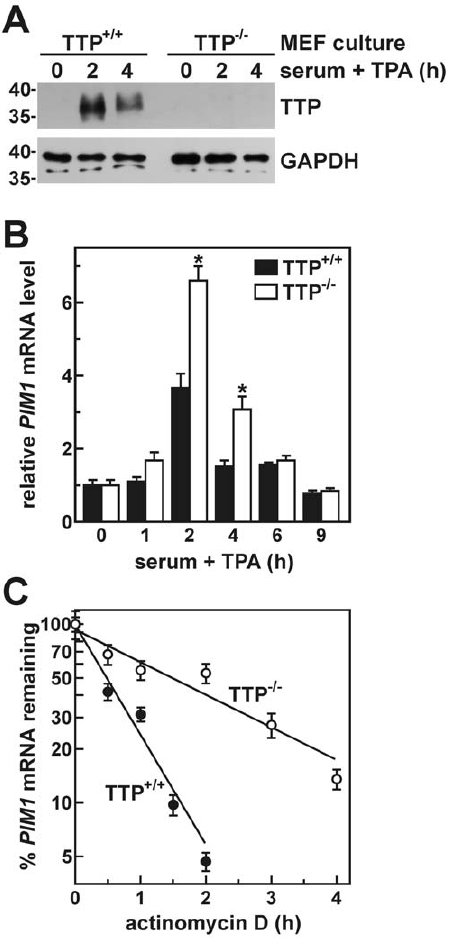
Figure 7. Regulation of PIM1 mRNA induction by TTP following mitogenic stimulation in MEF models. (A) Whole cell lysates were prepared from MEFs derived from TTP knockout mice (TTP 2 / 2 ) and wild-type littermates (TTP + / + ) following serum-starvation and stimula- tion with serum + TPA as described in ‘‘Materials and Methods’’. Expression of TTP and GAPDH were assessed at selected time points by Western blot, with the positions of molecular weight markers (in kDa) shown at left. (B) Total RNA was isolated from MEF cultures stimulated as described in (A). Bars show the relative level of PIM1 mRNA in TTP + / + ( solid bars ) and TTP 2 / 2 ( open bars ) MEFs at indicated times following mitogenic stimulation as determined by qRT-PCR and normalized to GAPDH mRNA (mean 6 SD of quadruplicate qRT-PCR reactions, * p , 0.01 versus TTP + / + ). Independent replicate experiments yielded similar results. (C) ActD was added to MEF cultures 2 hours after stimulation with serum + TPA. PIM1 mRNA decay rates were then measured as described in Figure 2, and yielded half-lives of 0.42 6 0.11 h ( n =4) for TTP + / + cells versus 1.56 6 0.12 h ( n =3) for TTP 2 / 2 ( p , 0.0001 versus TTP + / +